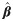
Scenario I. Coefficient of determination (R2) and root mean square error (RMSE) resulting from the solution of the linear regression problem with least-squares for the case recovery ratio (β^).